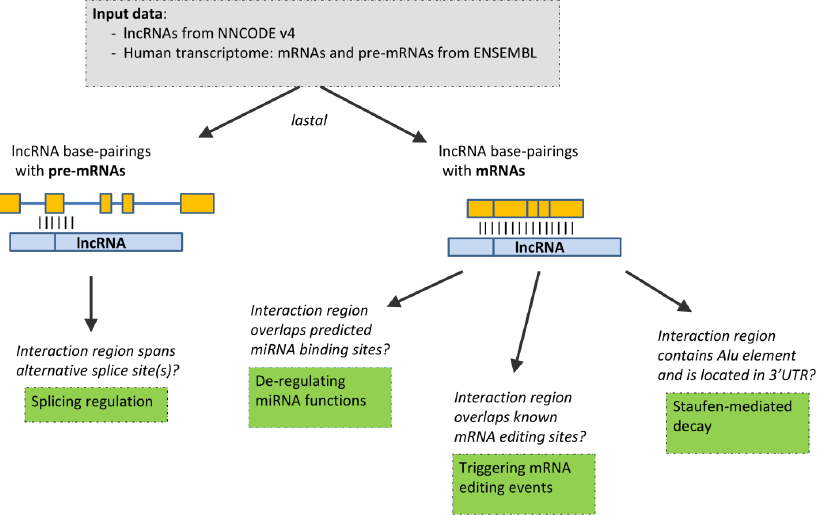
Fig 2. A summary of our approach aiming at identification of regulatory lncRNA-RNA